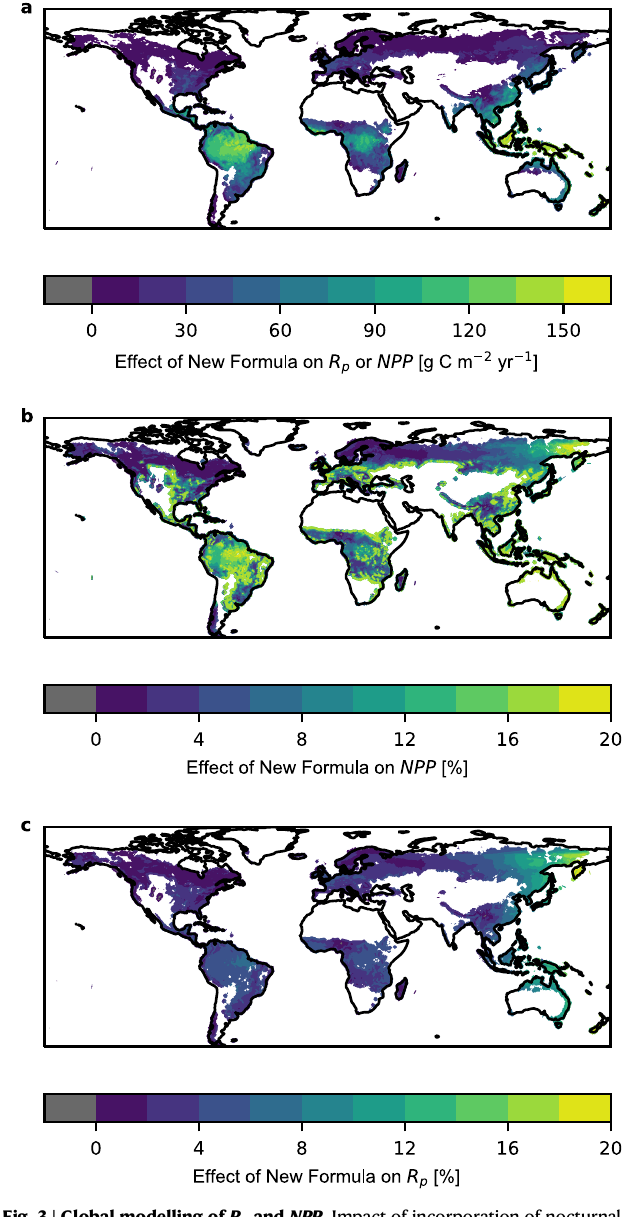
Fig. 3 | Global modelling of R P and NPP . Impact of incorporation of nocturnal variation in whole plant R To in a simulated reduction in plant respiration R p ( a , c ) and a corresponding increase in NPP ( b ) over the period 2000 – 2018 using the standard model with Q 10 =2 (Equation 1) and the new formula (Equation 4). The impact is estimated as the difference between the temporal mean of simulations withandwithoutnocturnalvariationinwholeplant R To (respirationrateatconstant temperature) for NPP (net primary production) and vice versa for R p (plant respirationrate)( a )andasapercentageofsimulationswithoutnocturnalvariation in R To ( b , c ). Note, that the reduction in R p ( a ) is identical to the increase in NPP in absoluteterms.Resultsarepresentedforgridcellswheregridlevel NPP is>50gm − 2 yr − 1 inthestandardsimulationswithQ 10 =2(therelativechangein R obtainedwith a 10°C change in T) to avoid excessively large % effects at very low